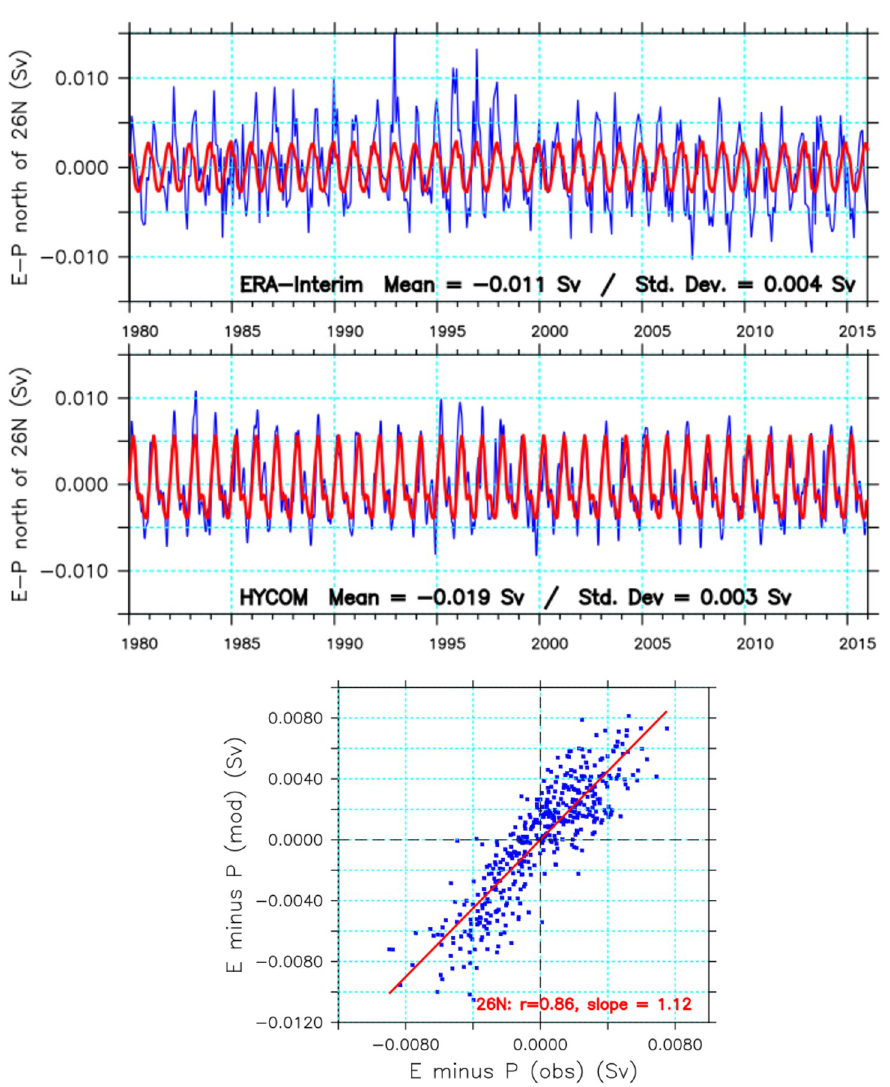
Fig 9. Time series of EMP from ERA-Interin (top) and GLBa0.08 (middle), with the 6-day sampled values shown in blue and the seasonal cycles in red. The bottom panel shows a scatter-plot of the two